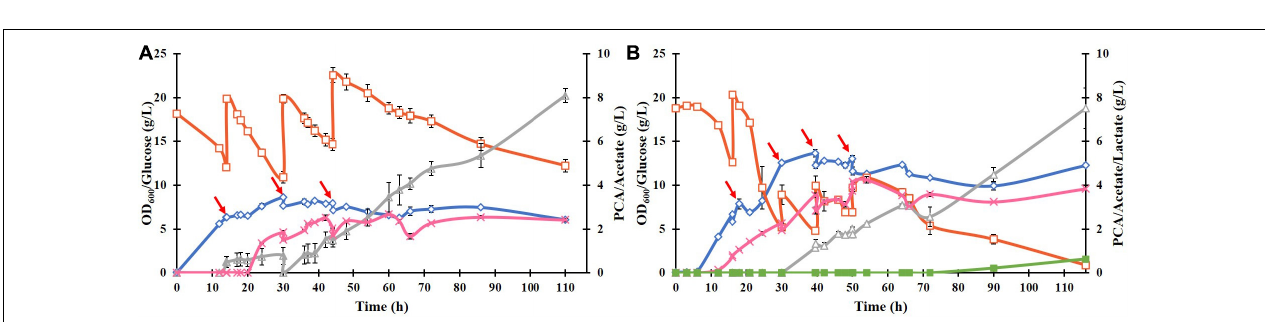
FIGURE 3 | Batch cultivation of E. coli ATCC 31882-DSD with the modified M9 medium in a bioreactor at pH 7, 37 ◦ C, and constant stirring rate at 600 rpm, with induction of gene expression at 0 h (A) . E. coli ATCC 31882 was grown as a control (B) . The cultivations were performed in duplicates. The symbols represent profiles of cell density measured as OD 600 ( ♦ ), concentrations of glucose ( (cid:3) ), PCA (x), acetate ( (cid:52) ), and lactate ( (cid:4) ).